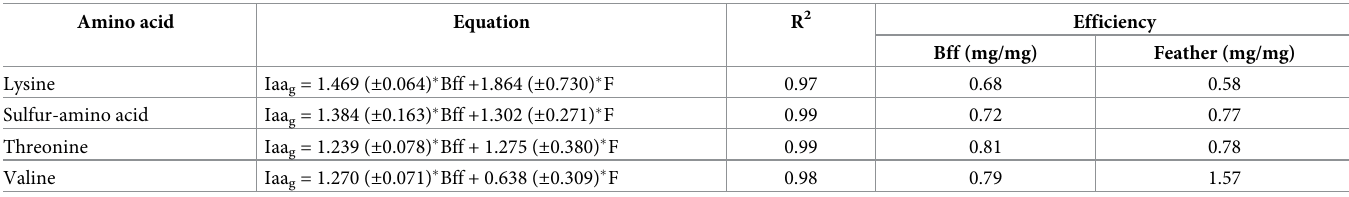
P-values of regression coefficients (b1 and b2) for feather-free body and feather estimated for lysine ( < .001 ; 0.0124), Sulfur-amino acid ( < .001 ; < .001), Threonine